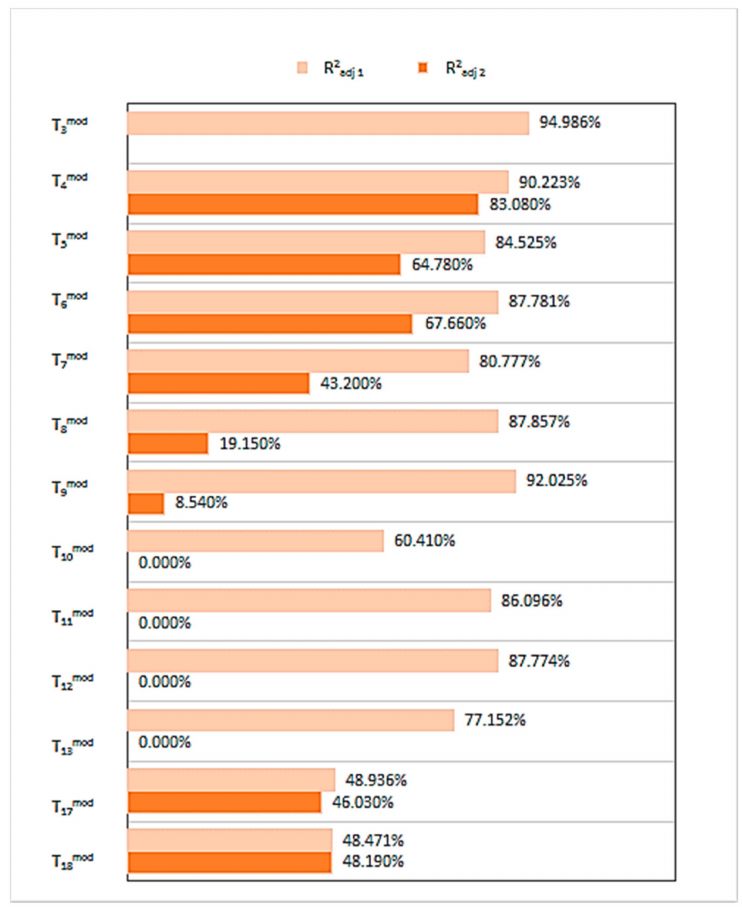
Figure 19. Values R 2 of modified regression models for the first phase— R 2 adj phase— R 2 (Source: own elaboration). adj 2